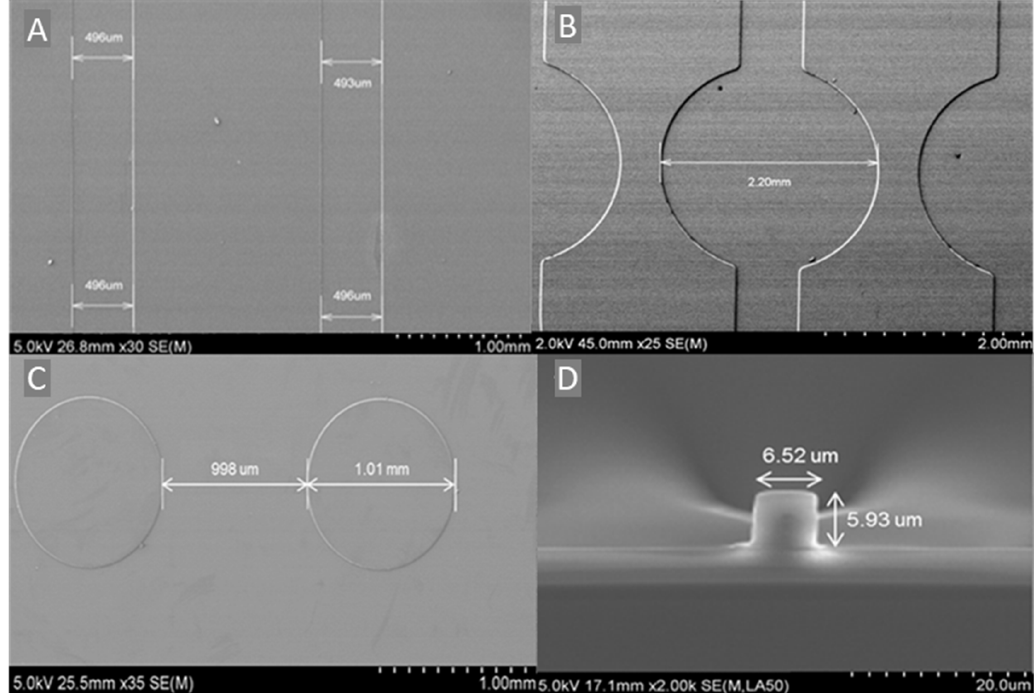
Figure 6. SEM images of ( A ) MFCs, ( B ) sensor spots, ( C ) pillars, and ( D ) cross-section of the optical waveguides.